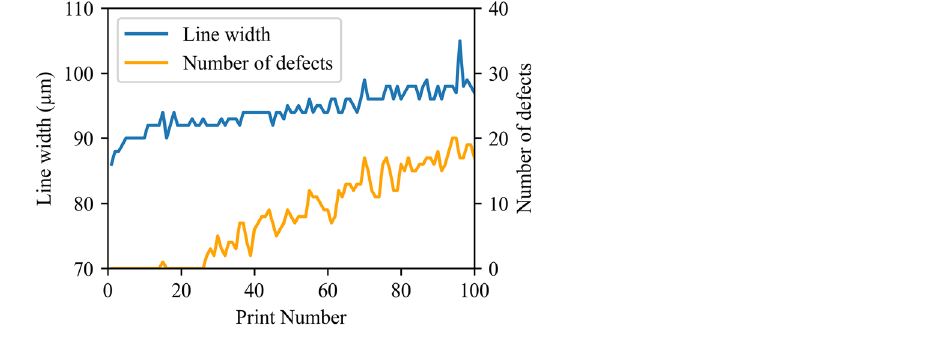
Figure 13. The measured line width of printed lines augmented by the number of local